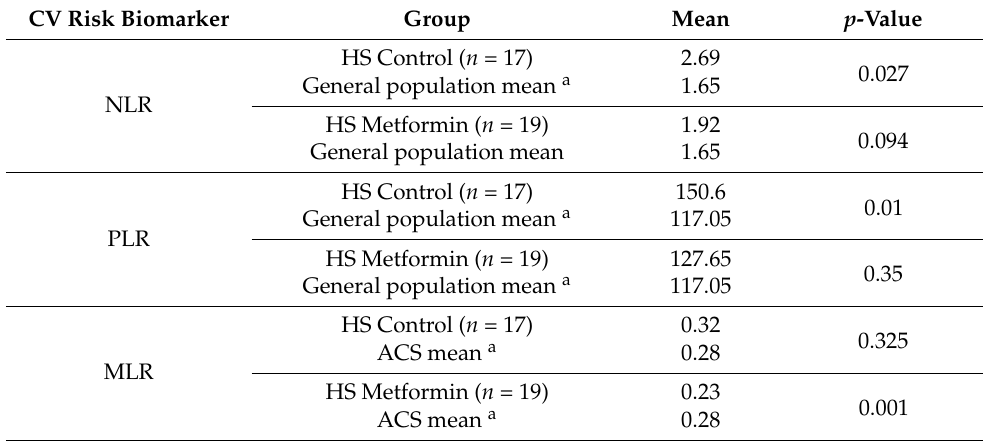
Table 3. NLR and PLR were higher in the HS control group than the general population mean but not significantly different in the HS metformin group compared with the general population mean. MLR was lower in the metformin group than the ACS mean.